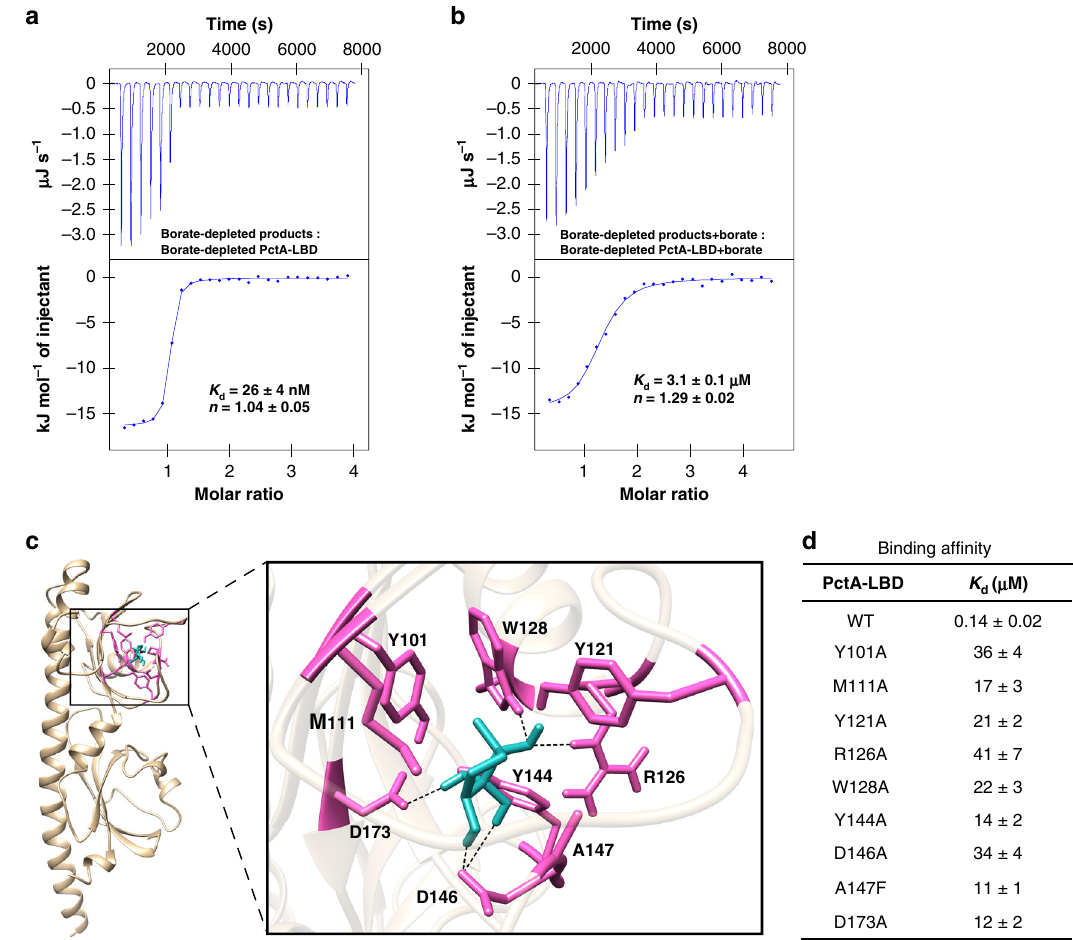
Fig. 4 The dCACHE domain of PctA prefers the nonborated form of AI-2. a , b Higher binding af fi nity of the products of the Pfs/LuxS reaction to PctA-LBD is detected under borate-depleted conditions. The binding af fi nity was evaluated using ITC analysis. In vitro reaction of SAH with Pfs and LuxS proteins was performed with plasticware and borate-depleted water, and concentration of DPD/AI-2 in the reaction products is ~13 μ M. Proteins were dialyzed against borate-depleted buffer before use. ITC data and plots of injected heat for automatic injections of the borate-depleted reaction products ( a ) or the borate- depleted products supplemented with 150 μ M boric acid ( b ) into the sample cell containing 1.3 μ M borate-depleted PctA-LBD ( a ) or borate-depleted PctA- LBD supplemented with 150 μ M boric acid ( b ) are shown in the upper and lower plots, respectively. Microcalorimetric data were corrected by subtracting the heats of dilution for ligand solutions injected into buffer (Supplementary Fig. 15b, c). Three independent ITC experiments were performed and similar results were obtained. The K d and binding stoichiometry ( n ) calculated by the NanoAnalyze software from three independent experiments are presented as mean ± s.d. c Predicted binding mode of R -THMF in the amino acid-binding pocket of PctA-LBD. PctA-LBD (PDB ID: 5T7M) 26 and R -THMF extracted from R -THMF-LsrB (PDB ID: 1TJY) 7 were used for Glide XP docking analysis. The conformation with the lowest docking energy is given via the Chimera software. The key residues of PctA-LBD involved in R -THMF binding are shown as purple sticks, and R -THMF is shown as cyan sticks. Five potential hydrogen bonds are indicated by dashed lines. d Binding of DPD/AI-2 (700 μ M) to PctA-LBD and its mutants (70 μ M) under normal conditions. The binding af fi nity was evaluated using ITC analysis. Data shown are mean ± s.d. of three biological replicates. WT,